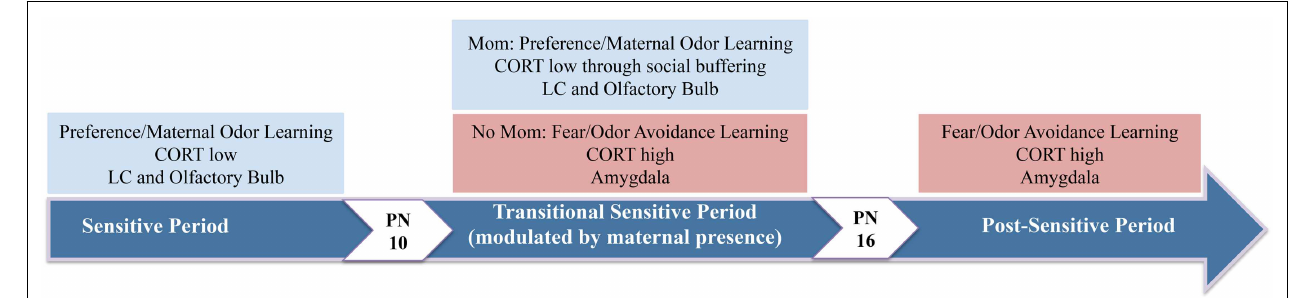
present at this age, pups will revert back to preference learning and the neural circuitry of the sensitive-period.Thus, the mother’s presence socially buffers pups (i.e., attenuates pups shock-induced CORT release) and pups learn a preference. As pups mature and enter the post-sensitive-period, odor-shock conditioning induces amygdala-dependent fear and odor avoidance learning (25,